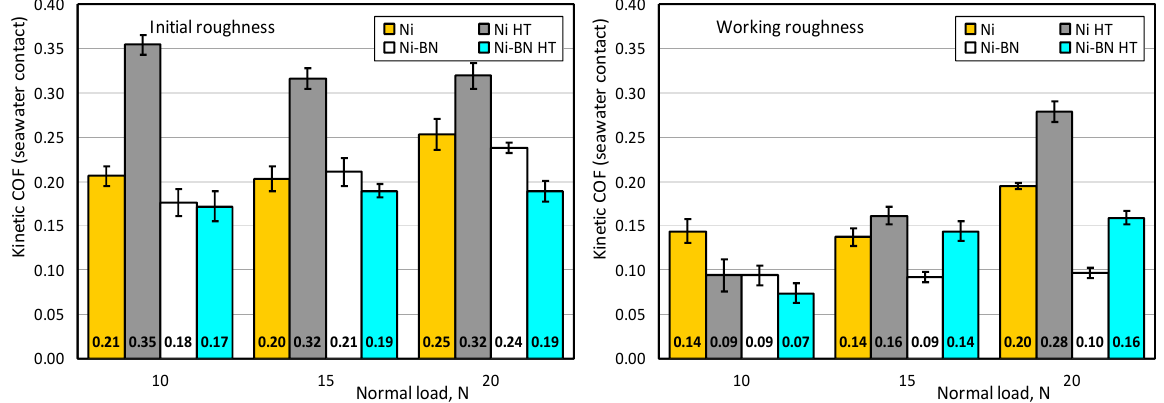
Figure 9. Kinetic coefficient of friction (COF) values and appropriate standard deviations of coatings with initial and working roughness, tested at different normal loads in seawater-lubricated contact conditions.